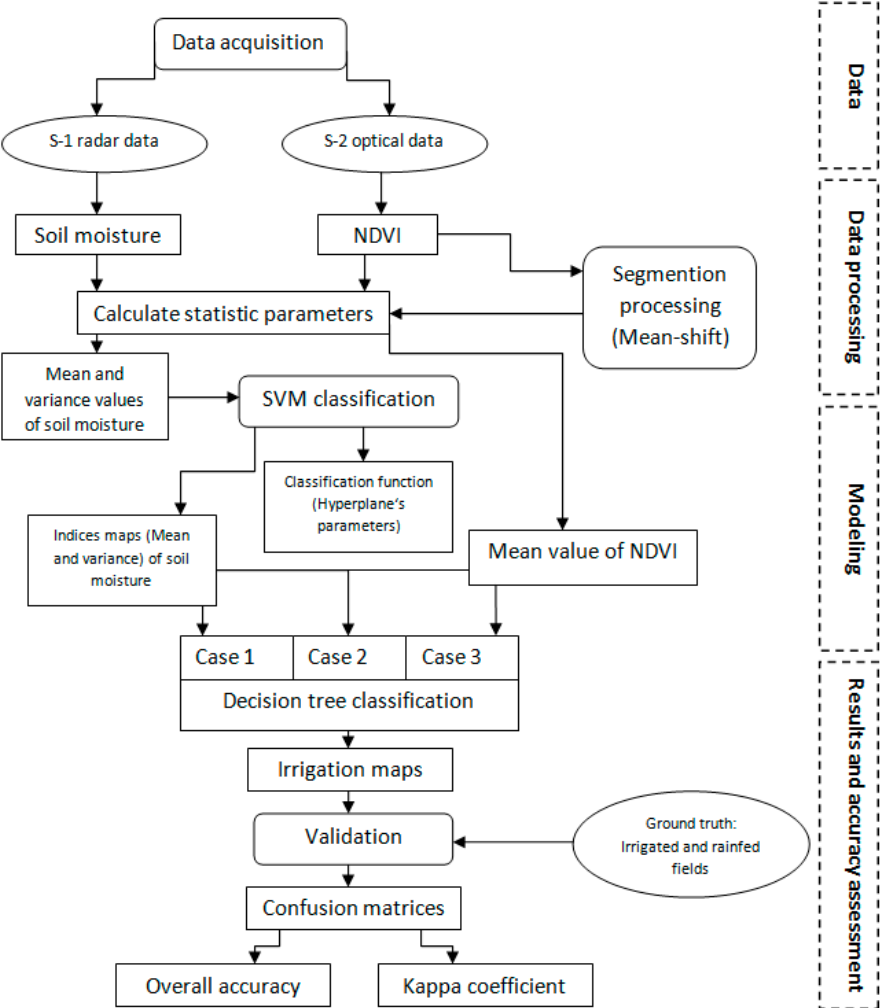
Figure 2. Flow chart of the irrigation mapping procedure, using SVM and Decision Tree